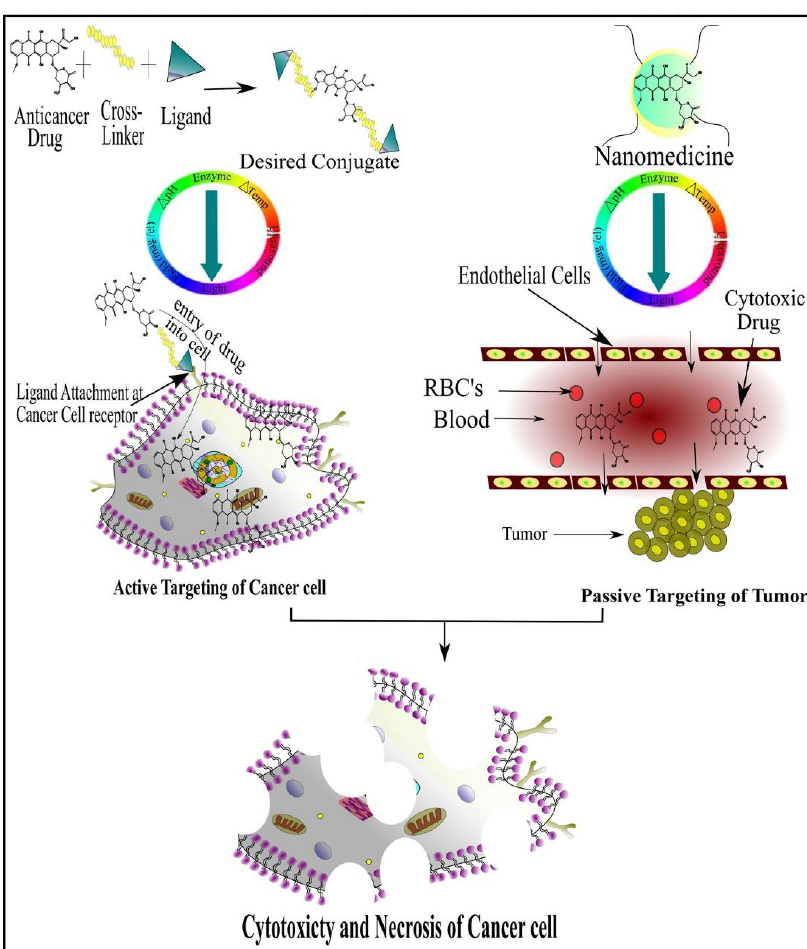
Figure 2. Cancer Cell-Specific Cytotoxicity by Active and Passive Targeting of Chemotherapeutic Agent(s). Table 1. Stimuli-Responsive Drug Delivery Systems for Cancer Chemotherapy.